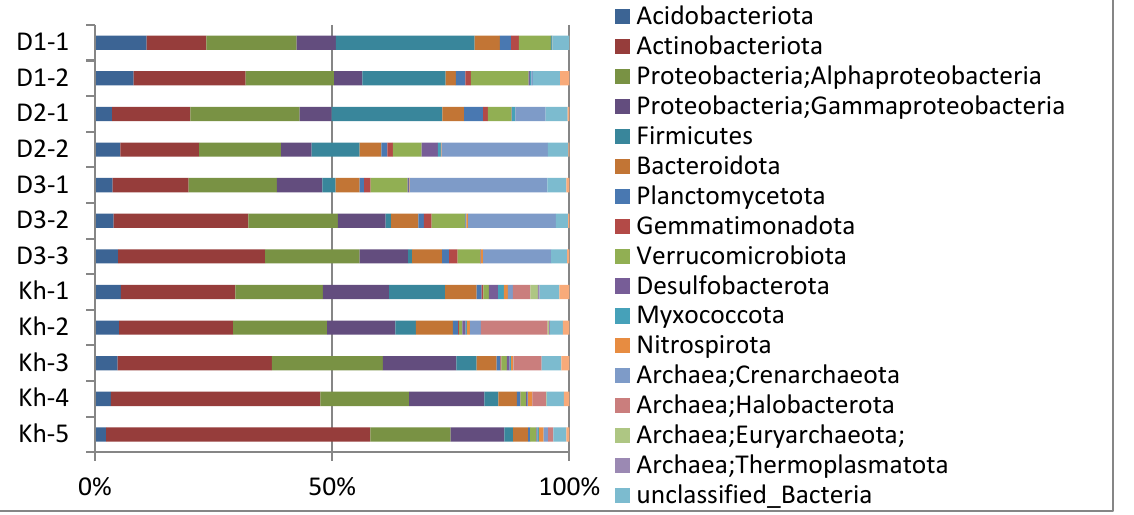
Figure 4. Relative abundance of bacteria and archaea on the phylum level in permafrost soils along the Darkhituy – Khaimisan transect.